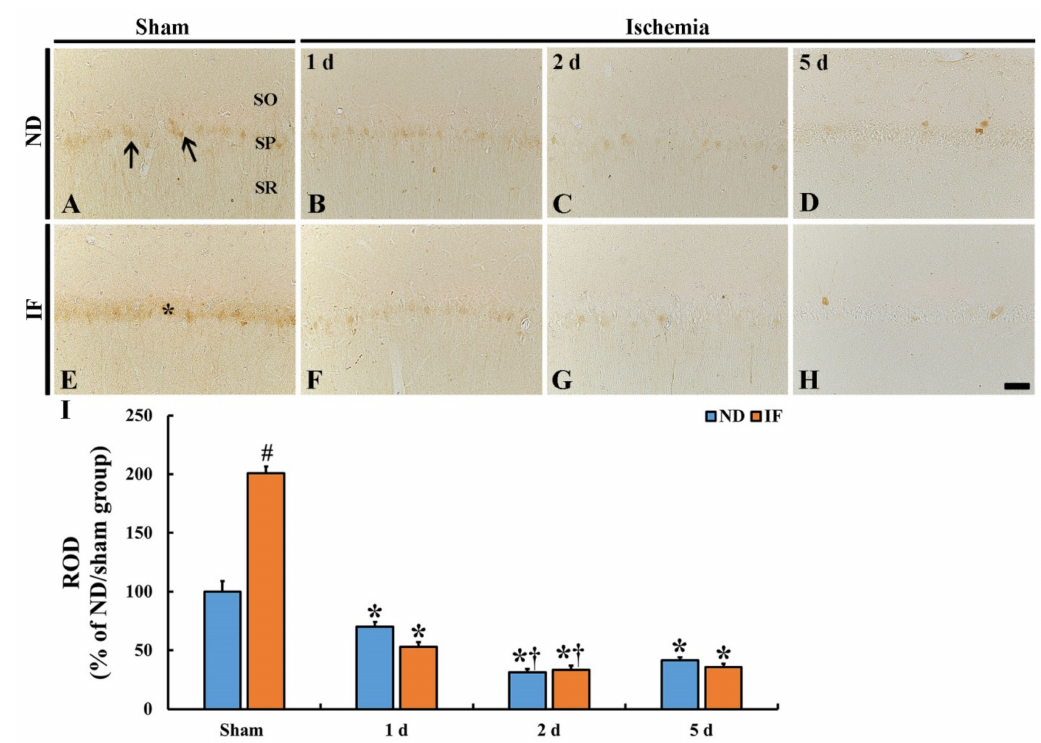
Figure 3. Calbindin D28K (CB) immunohistochemistry in the CA1 region of the ND (upper columns) and the IF (lower columns) groups at sham ( A , E ), 1 day ( B , F ), 2 days ( C , G ) and 5 days ( D , H ) after ischemia CB immunoreactivity is shown in CA1 pyramidal neurons (arrows). CB immunoreactivity in the CA1 pyramidal neurons (asterisk) in the IF/sham group is significantly higher than that in the ND/sham group. However, the CB immunoreactivities in both of the groups decreases gradually and similarly with time after ischemia. Scale bar = 50 µ m. ( I ) relative optical density (ROD) of CB immunoreactivity as percent value in the CA1 region ( n = 7 in each group, * p < 0.05 vs. ND/sham group, # p < 0.05 vs. corresponding time point group of ND group, † p < 0.05 vs. pre-time point group of each group by post hoc Tukey’s test). Bars indicate the means ± SEM. IF, intermittent fasting; ND, normal diet; SO, stratum oriens; SP, stratum pyramidale; SR, stratum